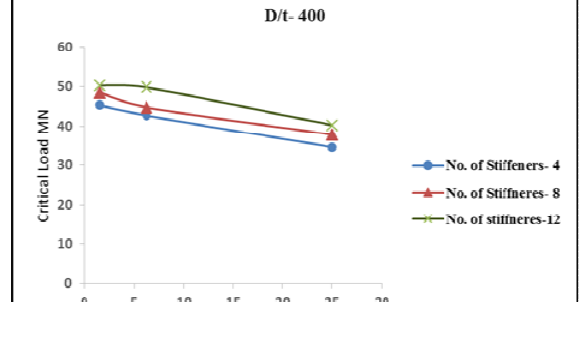
Paramters and resulting critical buckling load